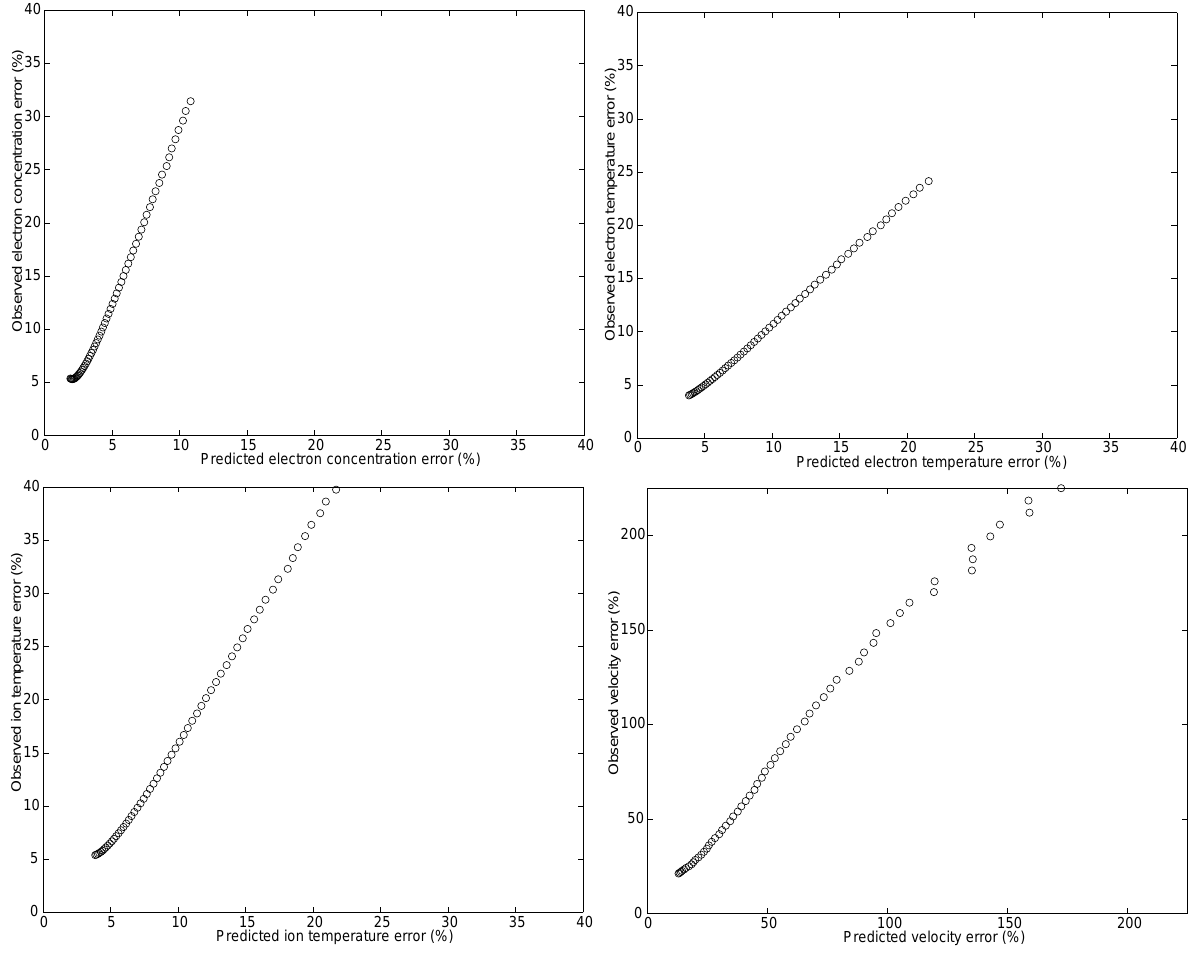
Fig. 2. A comparison of observed uncertainties (calculated from the polynomial fits) against predicted uncertainties (derived for the same bins of data using the theoretical formulae quoted in this paper) for the same sample channel as used in Fig. 1. As for Fig. 1, the panels show the fractional uncertainties in electron concentration, electron temperature and ion temperature and the uncertainty in line-of-sight